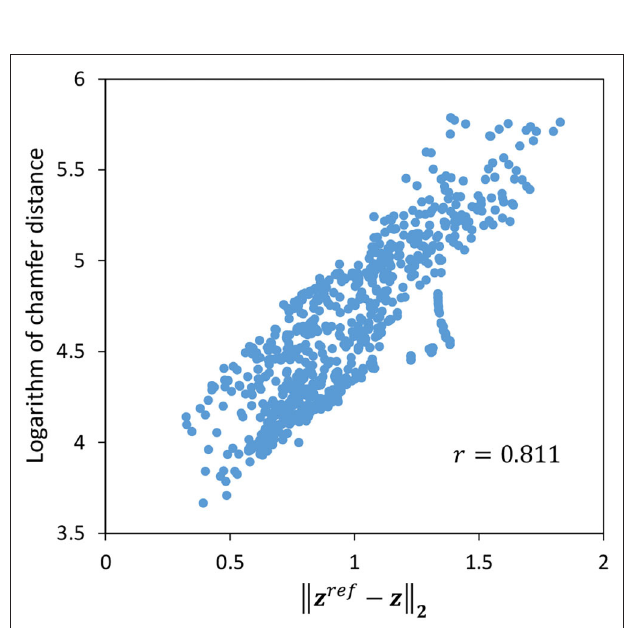
FIGURE 8 | The correlation between the logarithm of chamfer distance and || z ref − z || 2 .